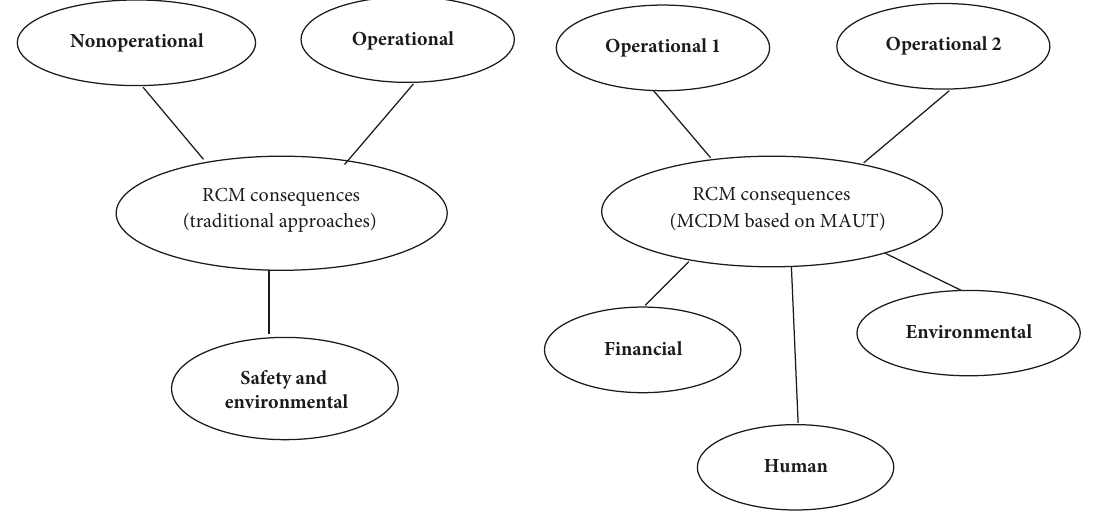
Figure 2: Comparison between conventional RCM and multicriteria RCM